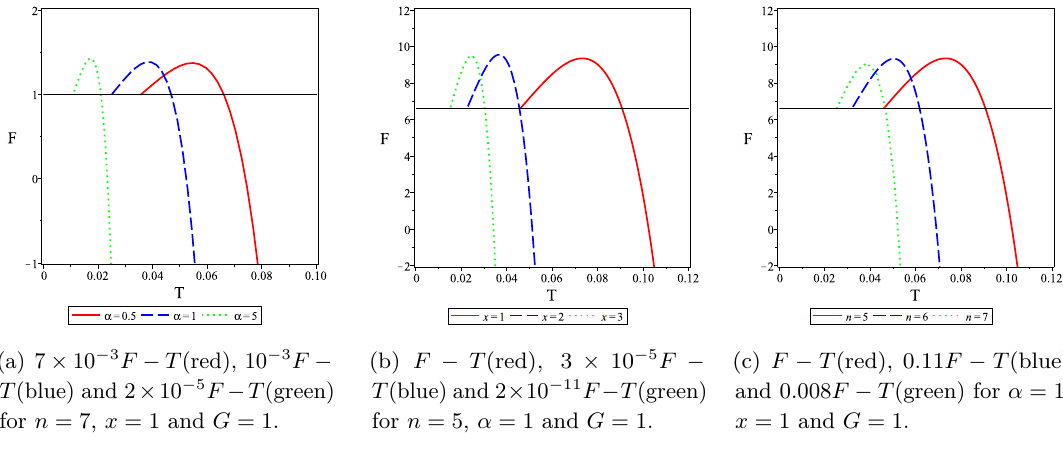
Figure 5 . Behavior of the free energy versus T for k = − 1 for “ − ” sign